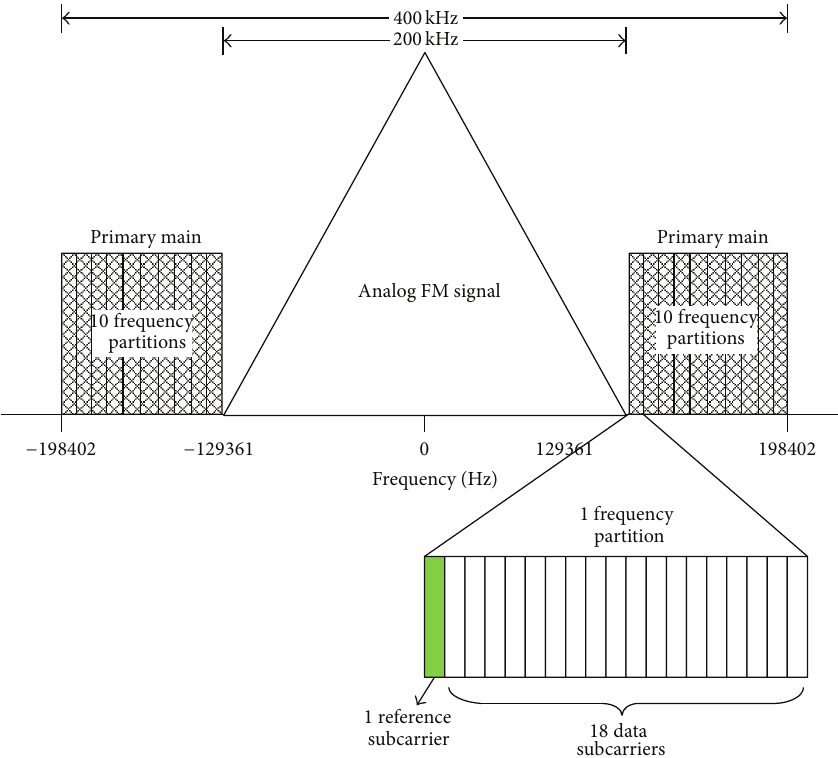
Figure 1: HD radio FM